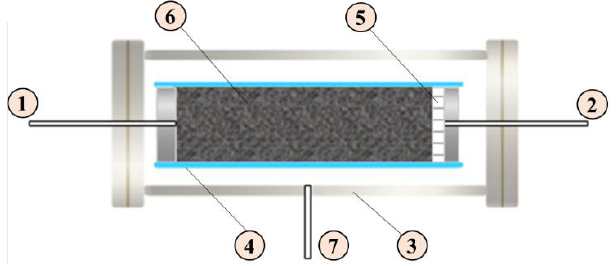
Figure 1. Static capillary-force tester based on semi-permeable membrane. ○ 1 . Fluid inlet; ○ 2 . wetting-phase outlet; ○ 3 . core holder; ○ 4 . rubber sleeve; ○ 5 . water wet diaphragm; ○ 6 . core; ○ 7 . confining pressure inlet.